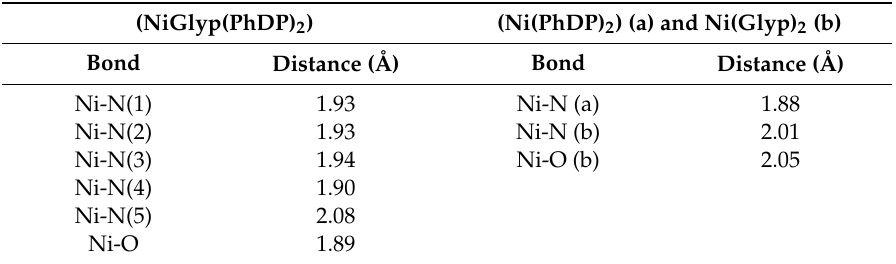
Table 5. Bond distances (Å) for the coordination atoms of the optimized structure (NiGlyp(PhDP) 2 ). Experimental values of (Ni(PhDP) 2 ) fragment ( a ) and Ni(Glyp) 2 ( b ) from the literature are provided for comparison [55,70].